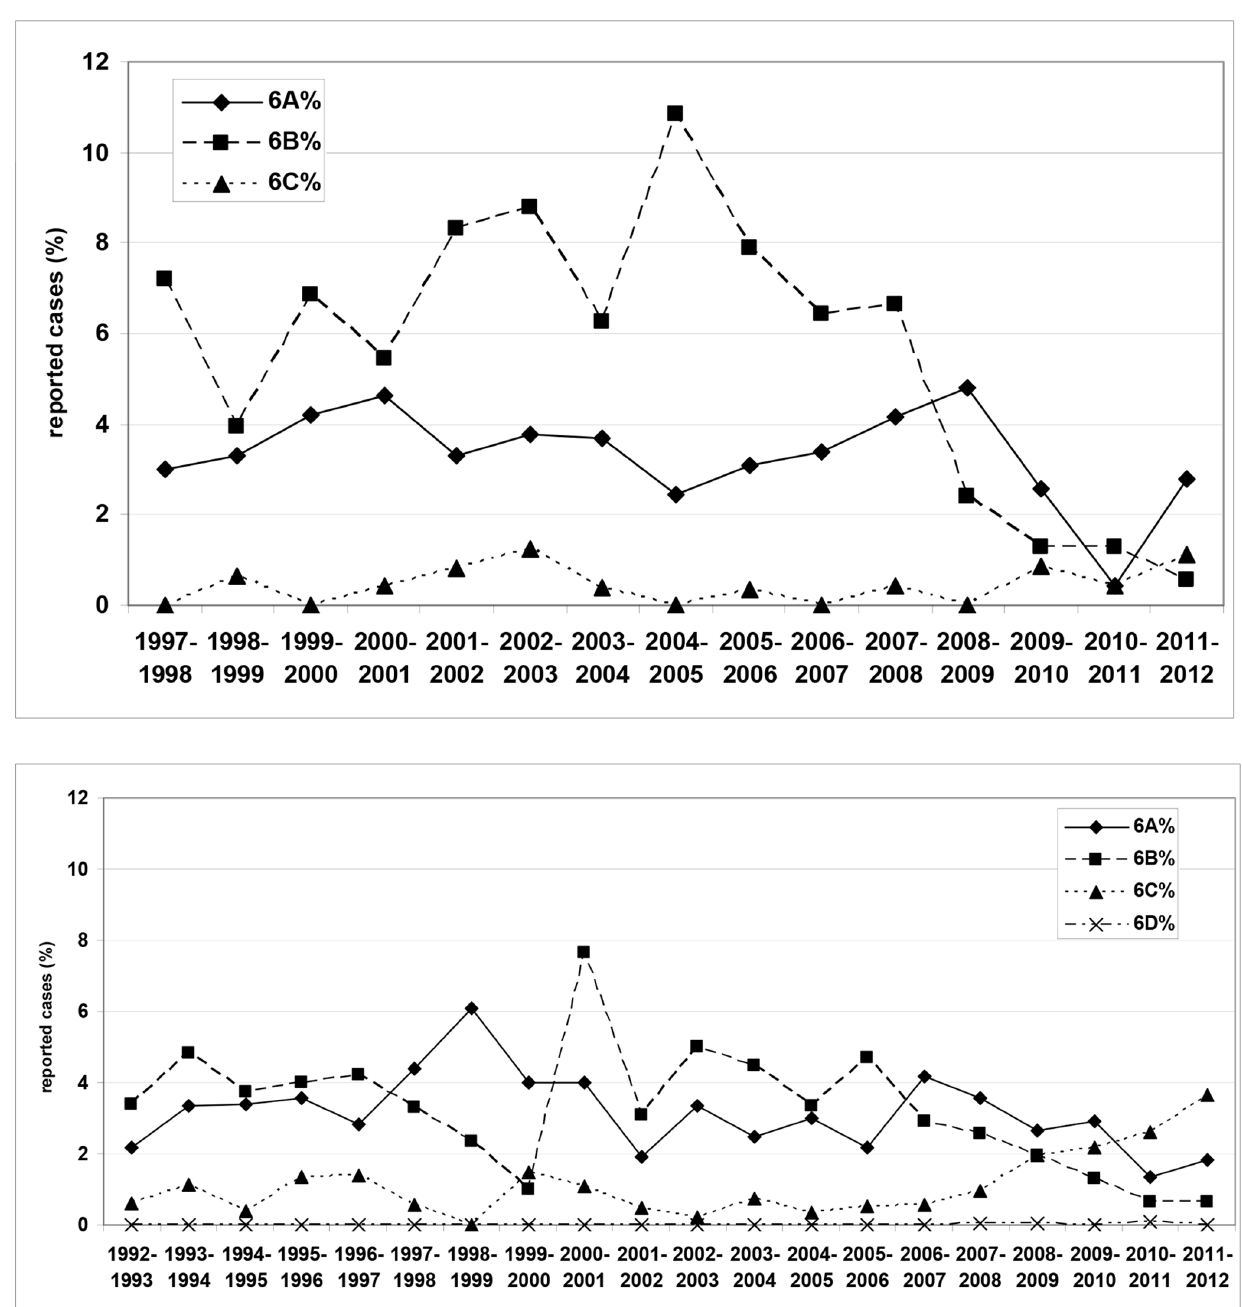
Figure 1. Prevalence of serogroup 6 serotypes over time among isolates from IPD among German children (top) and adults